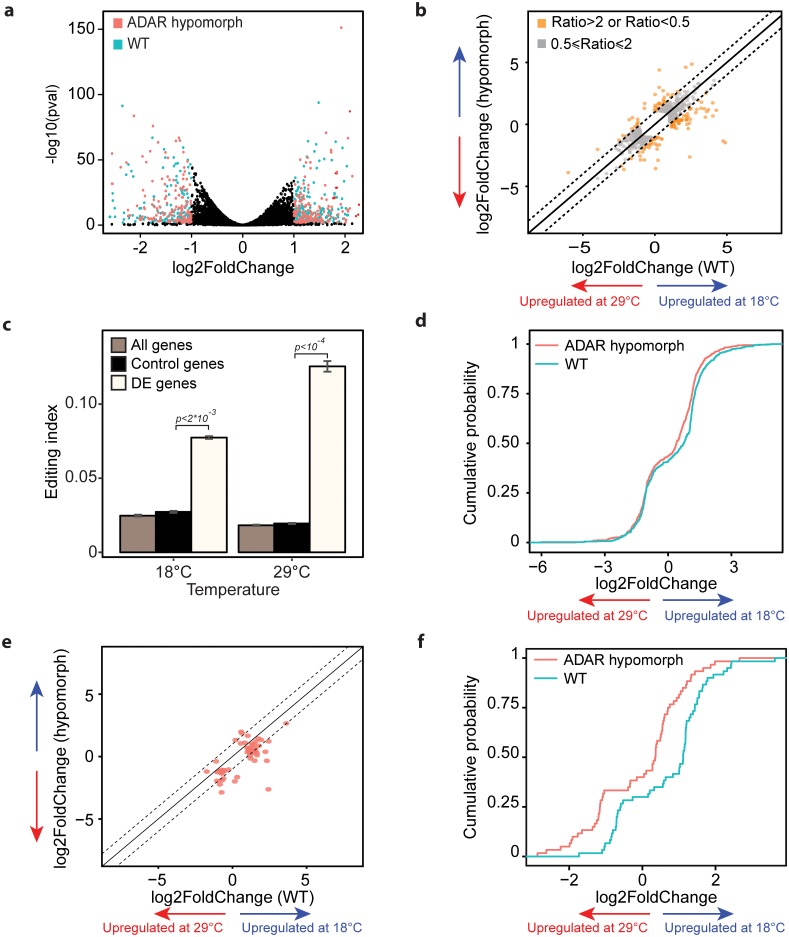
ADAR hypomorphs display weaker adaptation of their transcriptome to temperature shifts.(A) 'Volcano plot' showing gene expression differences in 29°C vs. 18°C in WT and ADAR hypomorph flies. Colored dots indicate genes significantly changing between the temperatures (p < 0.05, log2 (fold change) > 1). (B) Fold change levels of differentially expressed genes in 29°C vs. 18°C (selected as described in A) are plotted in a log scale WT against ADAR hypomorph. Orange dots indicate genes in which the fold change ratio between WT and ADAR hypomorph is > 2 or < 0.5 (C) Editing index, fraction of inosines among all expressed adenosines of all detected editing sites, for differentially expressed genes between control and ADAR hypomorph flies (light bars). Brown bars donate for editing index in all expressed genes. Black bars donates for editing index in control set of 60% most expressed genes. The p.values were calculated using bootstrapping exam with 10,000 random sampling from the control set. The editing levels were calculated on wild type CantonS strain. (D) Cumulative distribution plot for all genes differentially expressed between 29°C and 18°C. Kolmogorov-Smirnov test was used to determine the statistical significance of the differences between the curves (p < 0.0001). (E) Fold change levels of differentially expressed genes in 29°C vs. 18°C that are affected by ADAR hypomorph only in 18°C. Plot was generated as described in B. (F) Cumulative distribution plot of genes differentially expressed at 29°C vs. 18°C that are affected by ADAR hypomorph only in 18°C. Kolmogorov-Smirnov test was used to determine the statistical significance of the differences between the curves (p < 0.001).